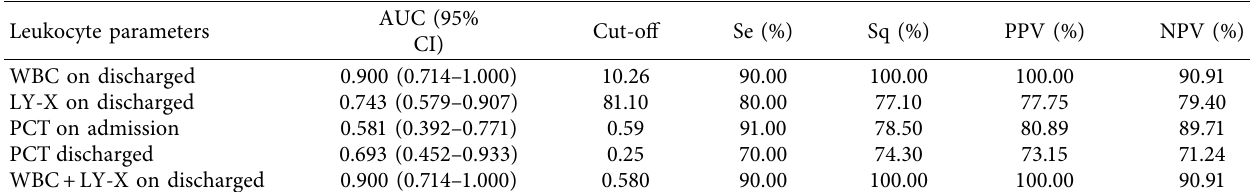
Table 8: Predictive value of leukocyte parameters for clinical outcome in patients with